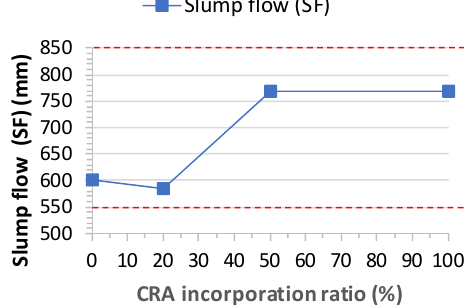
Figure 8. Slump flow test results.